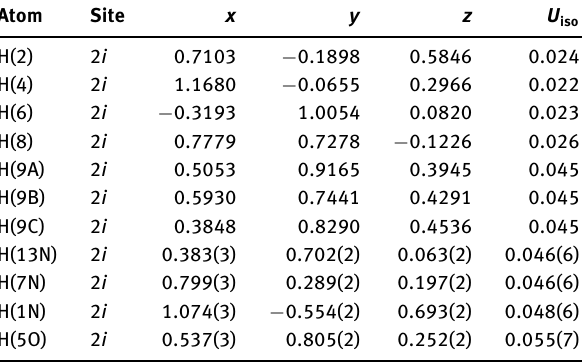
Table 2: Fractional atomic coordinates and isotropic or equivalent isotropic displacement parameters (Å 2